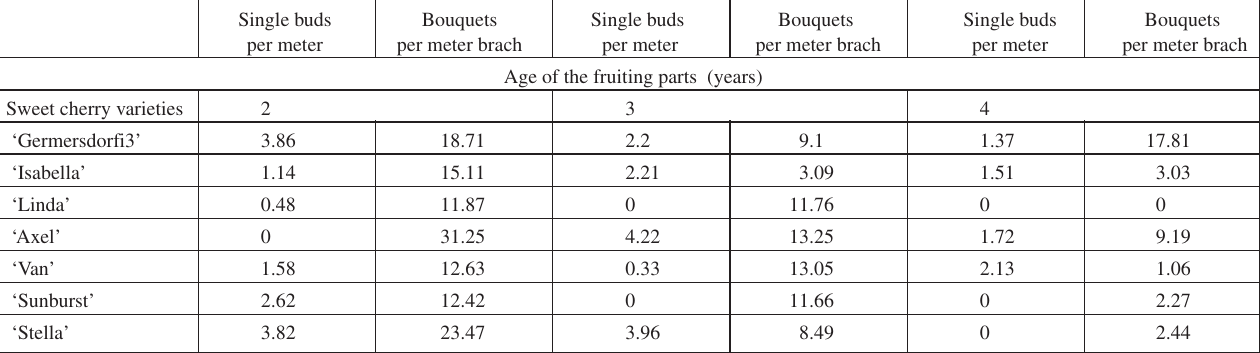
Table 1: Fertility of fruiting parts of different age in cherry varieties (Debrecen-Pallag,